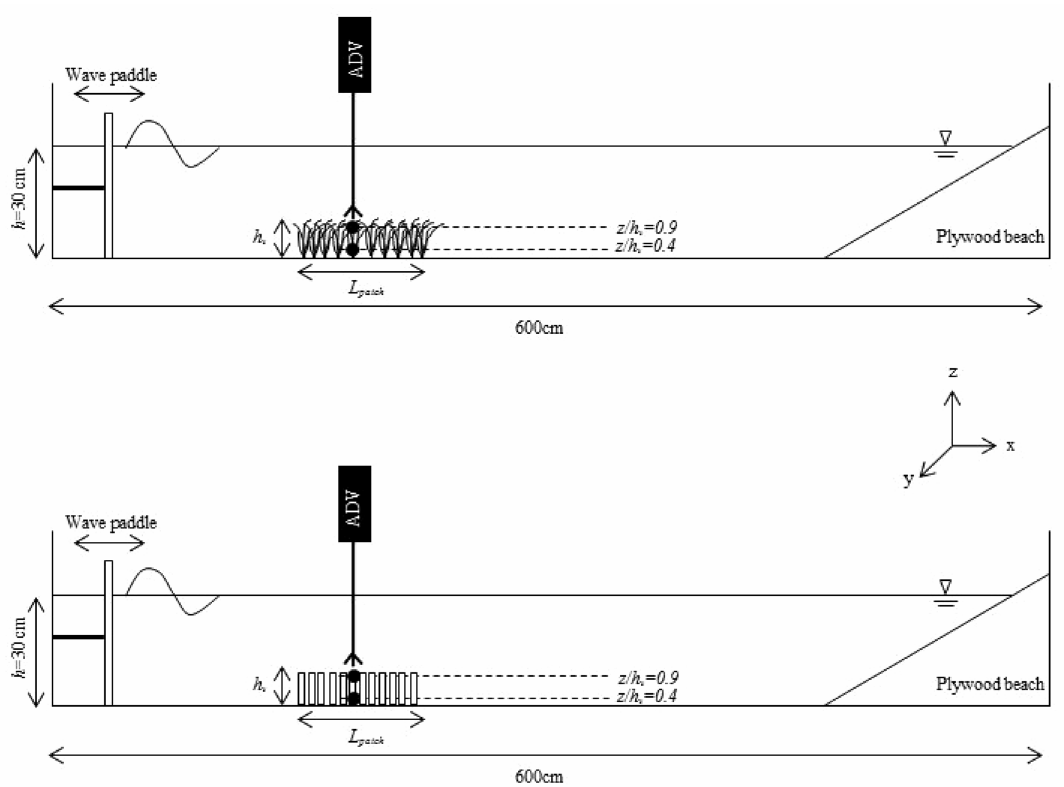
Figure 6. Lateral view of the experimental setup, with the wave paddle on the left. Experiments were conducted in a 600 × 50 × 50 cm long flume, with a mean water depth of 30 cm. The model patch had lengths that ranged from 2.8 to 42 cm and a patch height of effective height h v . The triangle at the water–air interface represents the water level in the flume. An ADV was vertically mounted to measure the instantaneous velocities at selected vertical heights. The upper panel corresponds to the case of flexible plants and the bottom panel to rigid plants.